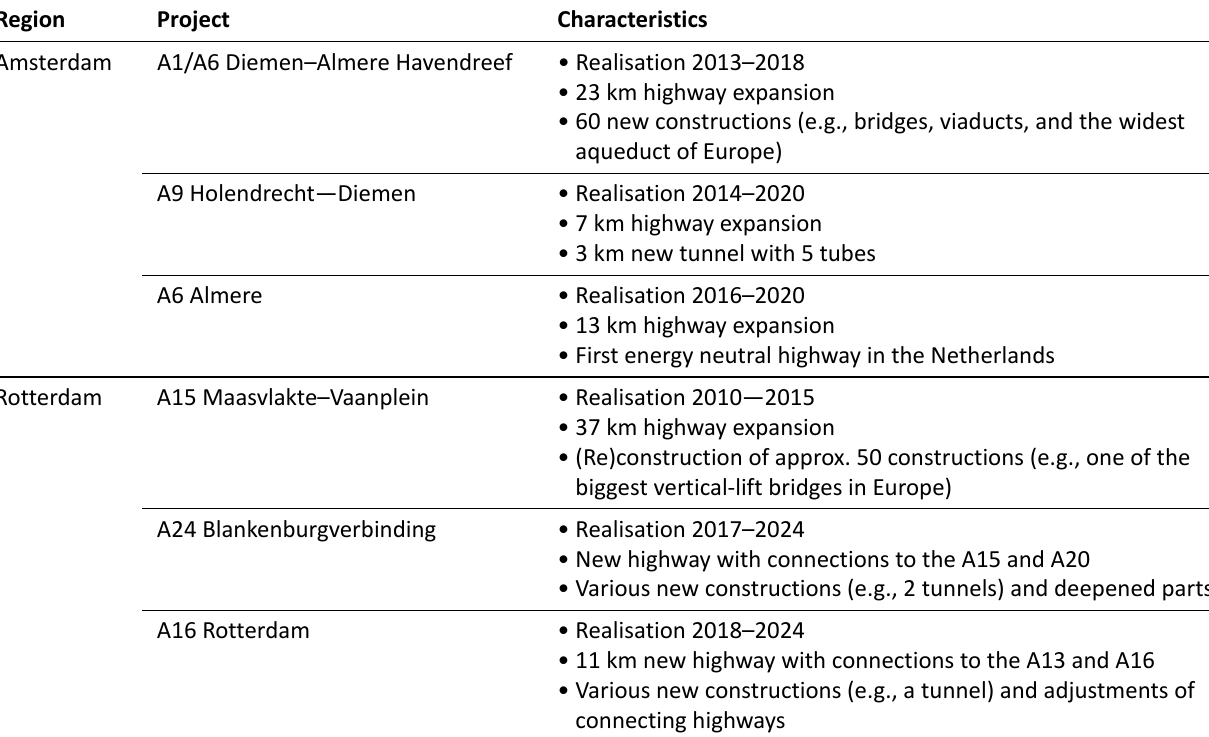
Table 1. Information about the projects selected. Region Project